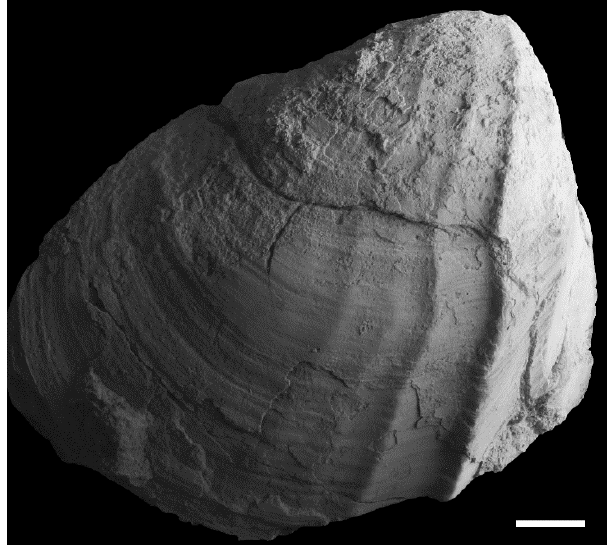
Figure 13. Healed shell damage in Pholadomya protei , Callovian, Bol ę cin, Polish Jura (specimen MGUS.Sz.3924, whitened with ammonium chloride).